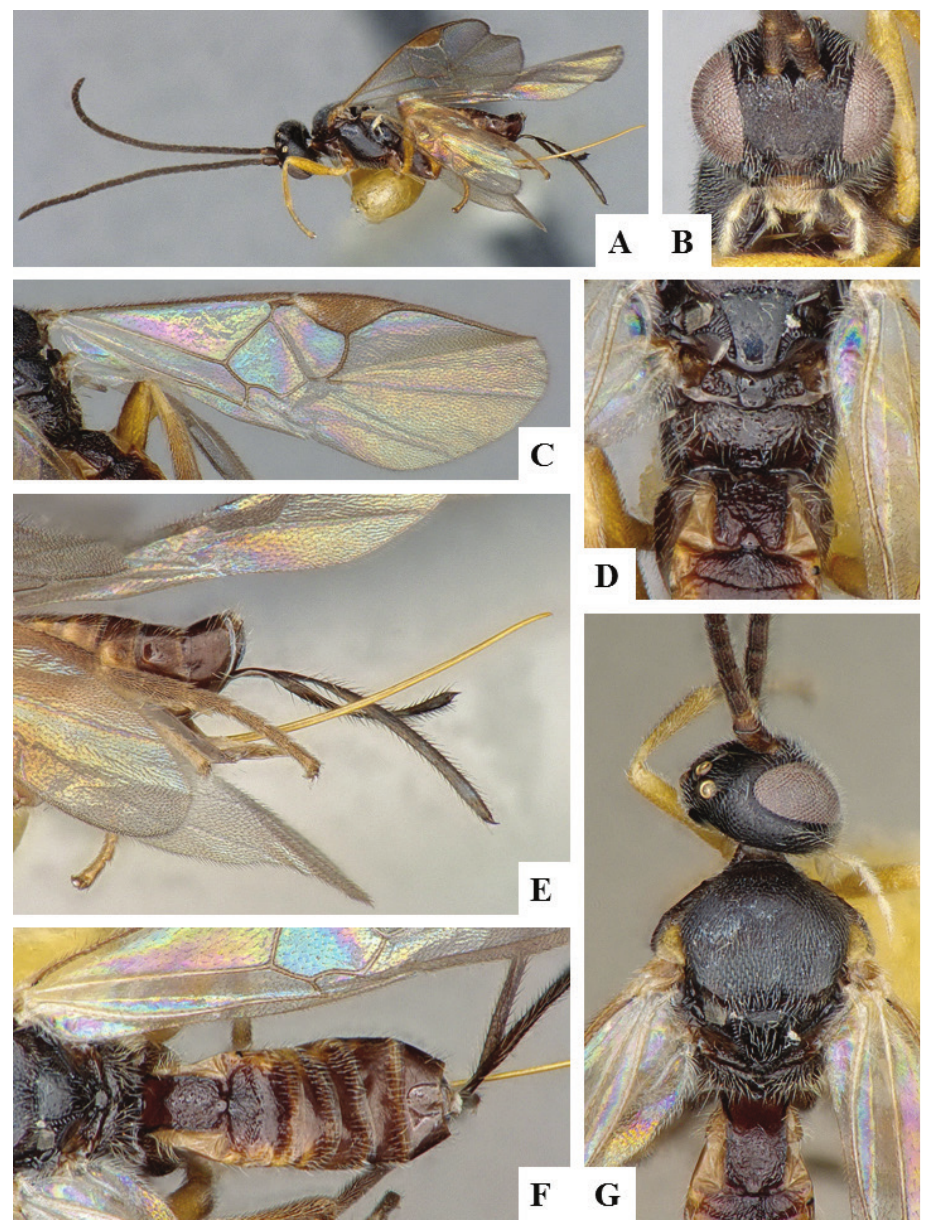
Figure 21. Dolichogenidea paralechiae. A Habitus, lateral B Head, frontal C Wings D Mesosoma and metasoma (partially), dorsal E Metasoma, lateral F Metasoma, dorsal E Head and mesosoma,